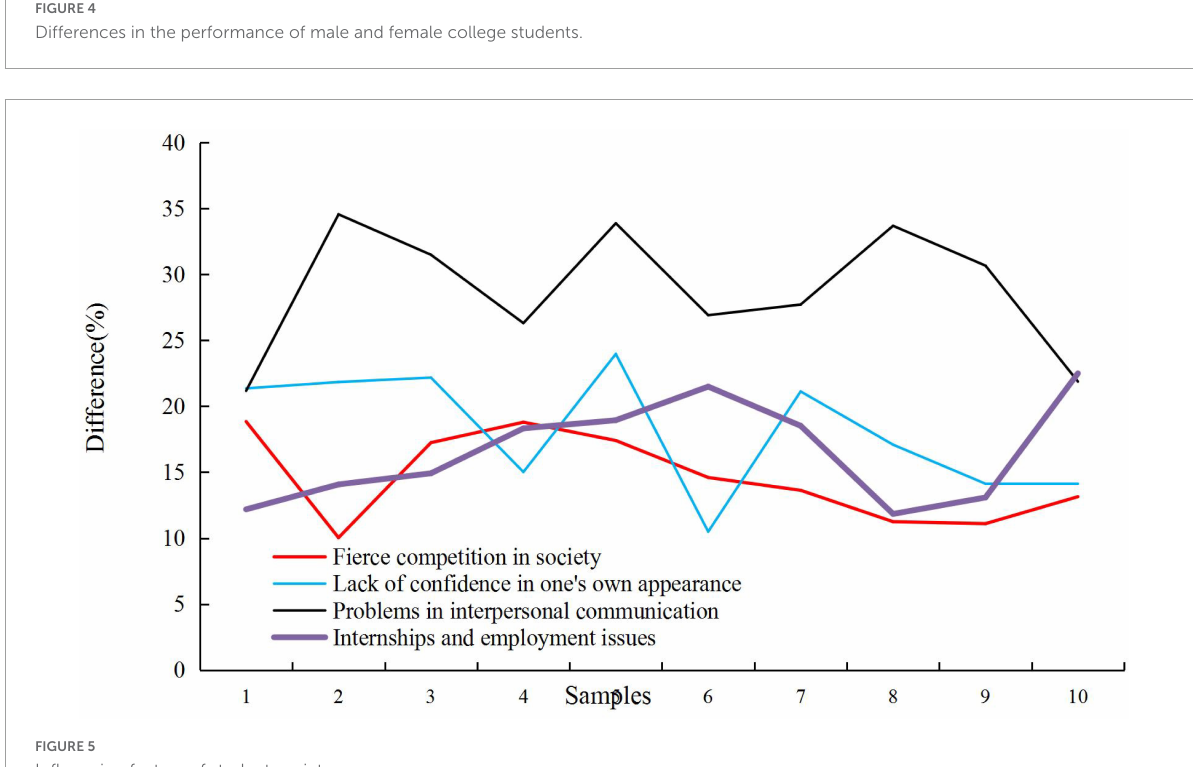
FIGURE5 Influencing factors of student